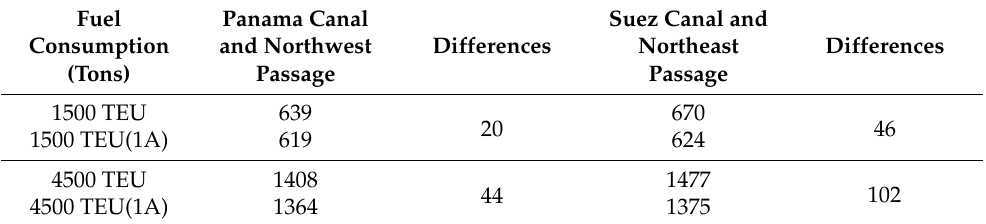
Table 4. Fuel consumption along different sea routes.